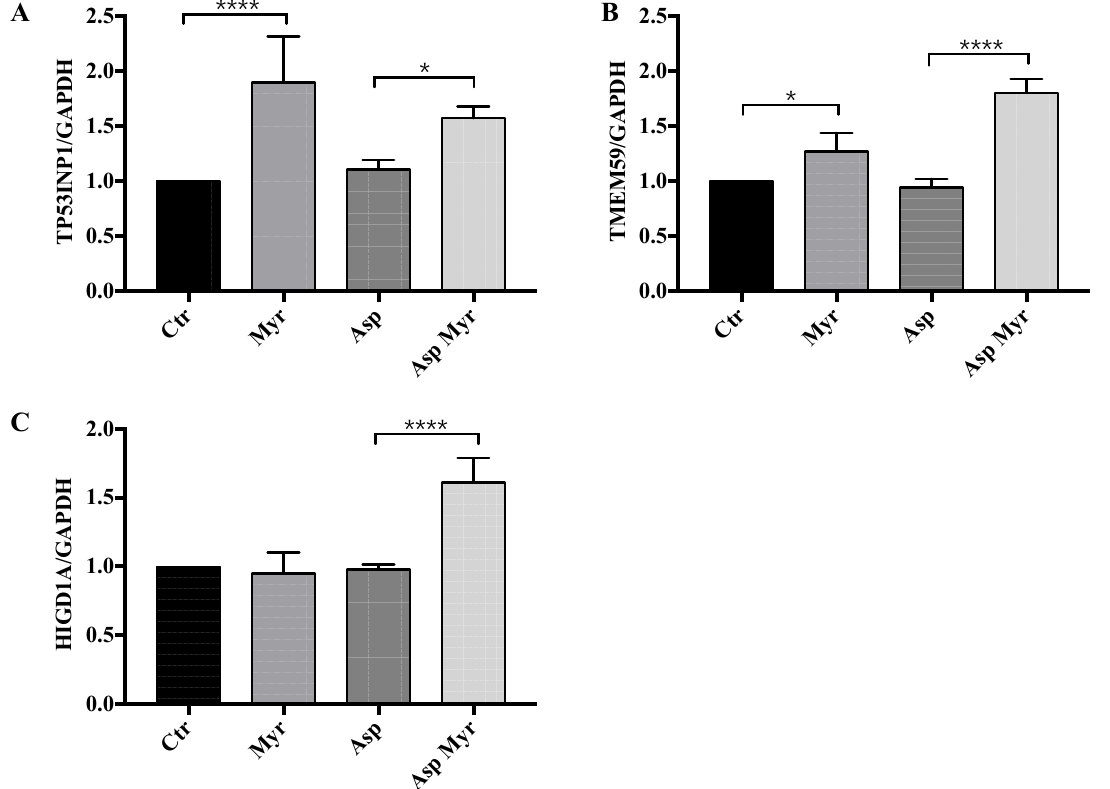
Figure 7. RNA-seq validation by RT-PCR quantification of the expression of genes involved in response to infection in CF cells: ( A ) transmembrane protein TMEM59; ( B ) p53-inducible protein 1, TP53INP1 ; ( C ) hypoxia inducible gene 1, HIGD1A. GAPDH was used as a housekeeping gene. Data, derived for triplicate samples, are expressed as mean ± SE (* p < 0.05; **** p < 0.0001); two-way ANOVA followed by Bonferroni correction was used for all data.